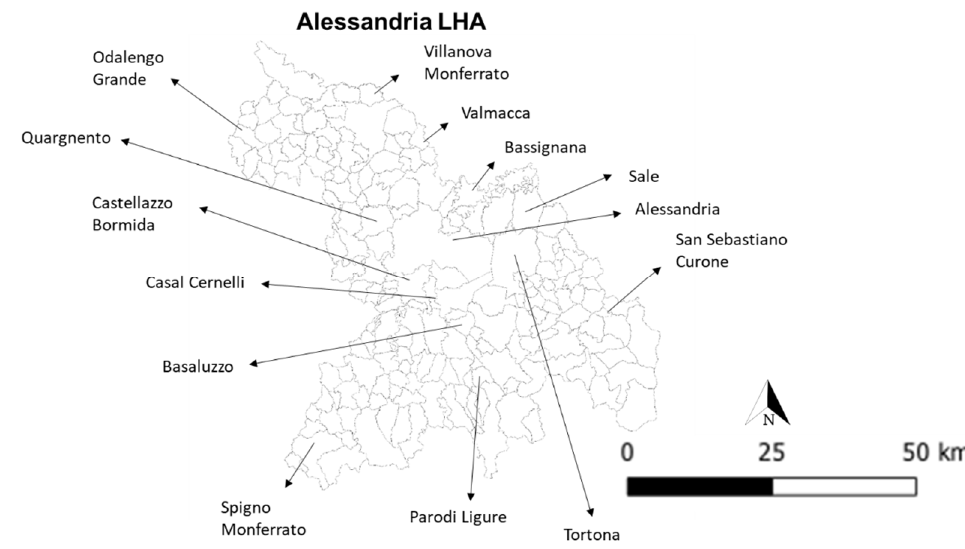
Figure A1. Maps of the area of Alessandria LHA reporting the main towns or the towns cited in the manuscript.